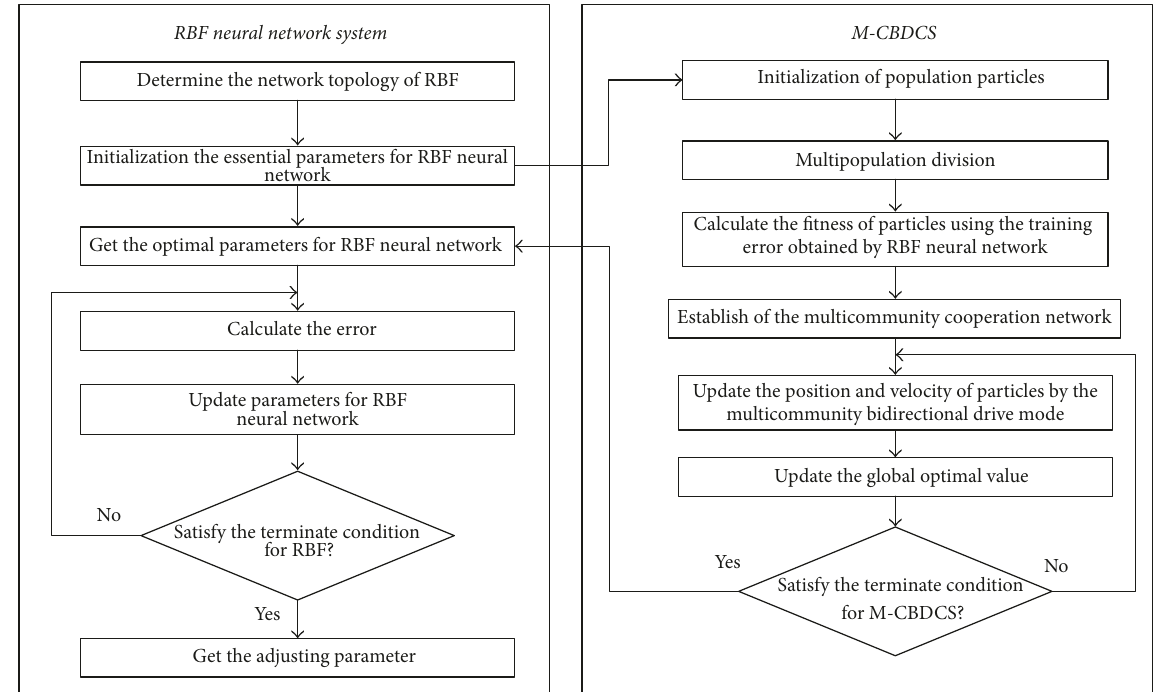
Figure 5: The flow diagram about the adaptive RBF neural network with the optimization of M-CBDCS.